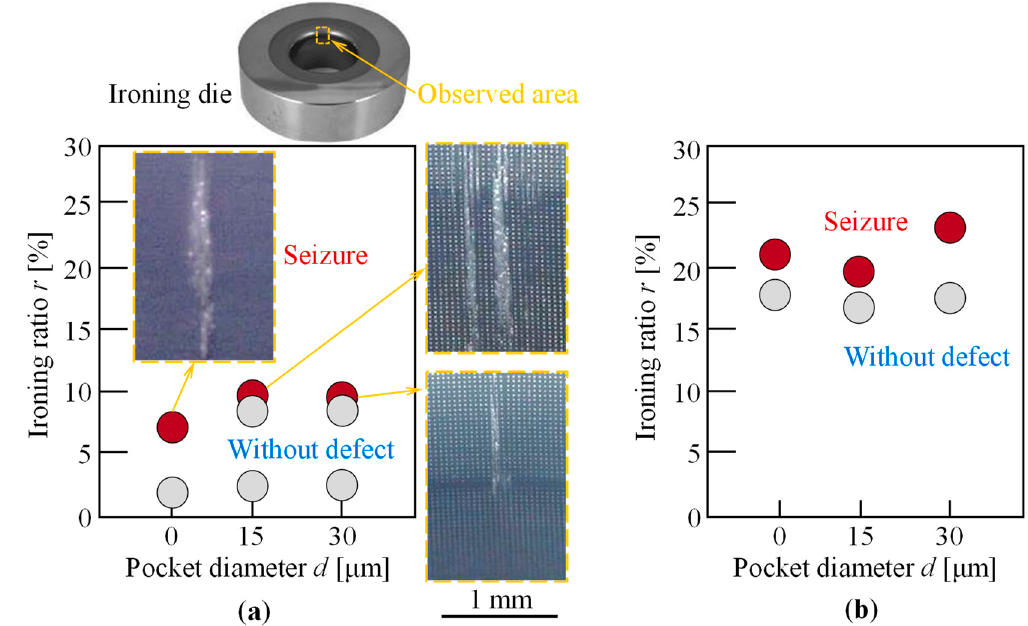
Figure 18. Ironing limit of laser textured dies having lubricant pockets used to iron SUS430 stainless steel cups by applying lubricant ( a ) without an extreme pressure additive, and ( b ) with an extreme pressure additive.